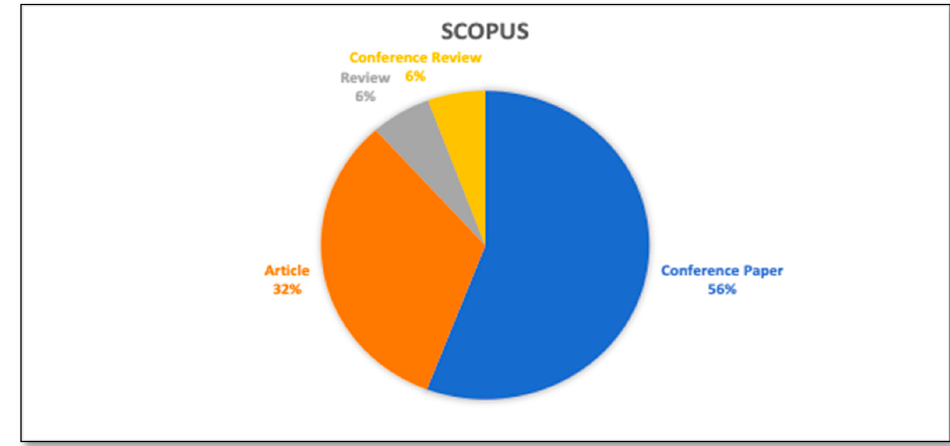
Figure 7. Analysis of documents by type. (Scopus database). Table 5. Publication count by document type (Scopus database).